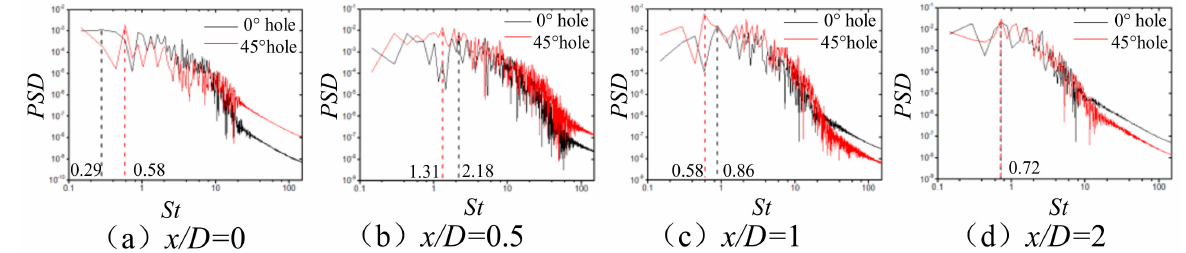
Figure 12. Power spectral density of radial fluctuating velocity near the target surface.